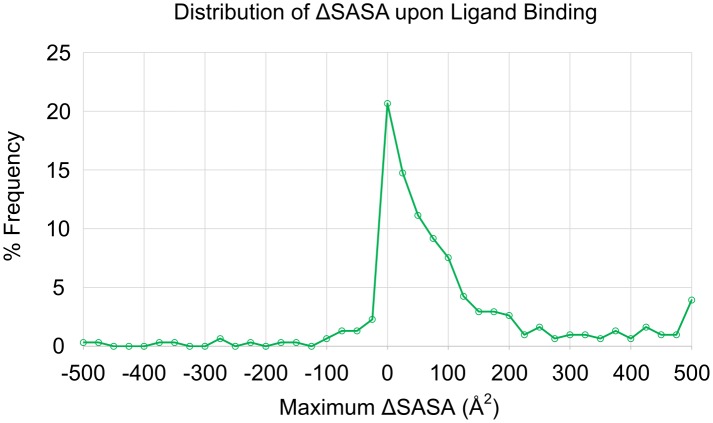
Distribution of the maximum change in solvent accessible surface area of unified binding-site residues.ΔSASA was calculated as maximum Holo SASA—minimum Apo SASA.